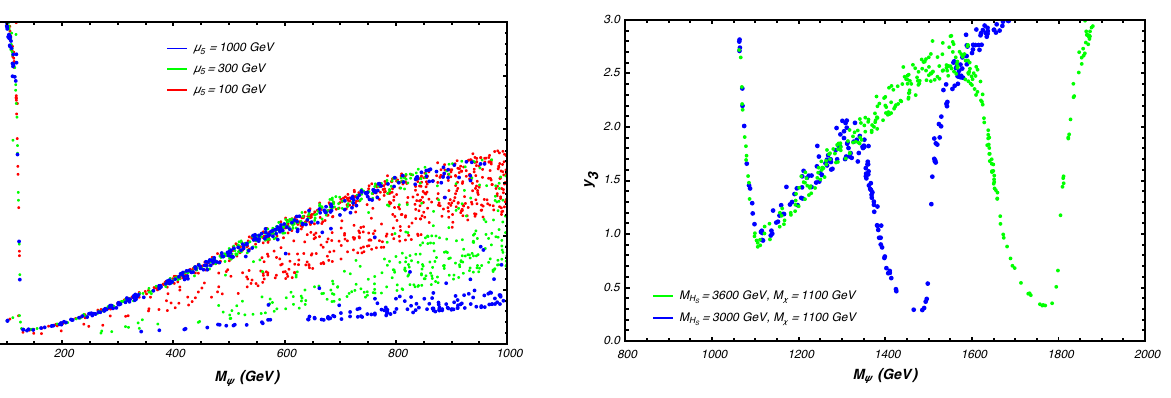
Fig. 12 y 3 vs M ψ for fixed M H and M χ values, showing the presence S of the annihilation channel ψψ → χχ and the resonant behaviour with = 2 M M H S